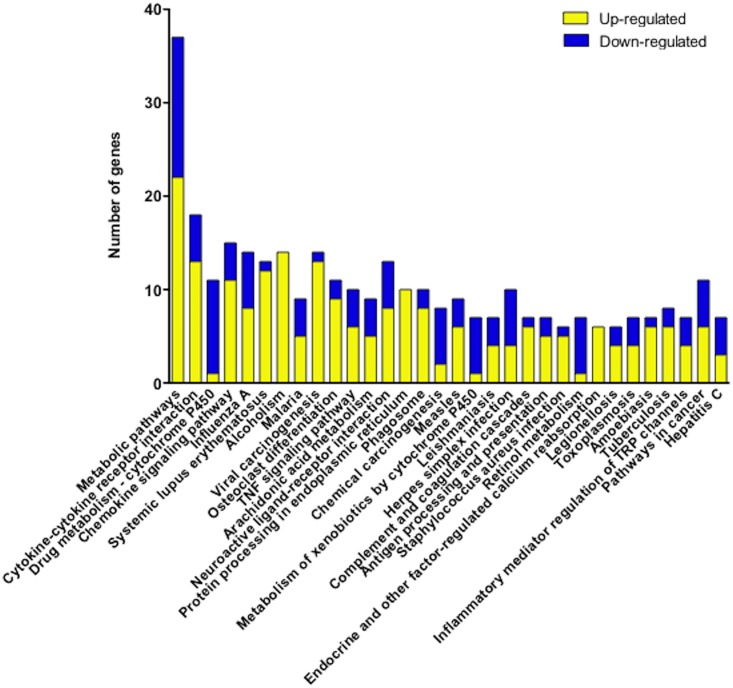
Kyoto Encyclopedia of Genes and Genomes (KEGG) pathway analysis of differentially expressed genes in bronchial smooth muscle tissues of the antigen-challenged mice. Significantly affected pathways are shown (adjusted P-value < 0.05 by Bonferroni). Total RNA sample of each mouse (4 animals, respectively) was subjected to the microarray analysis, and KEGG pathway analysis of differentially expressed genes was performed. Each column represents the number of up- (yellow) and down-regulated (blue) genes in the indicated pathway.